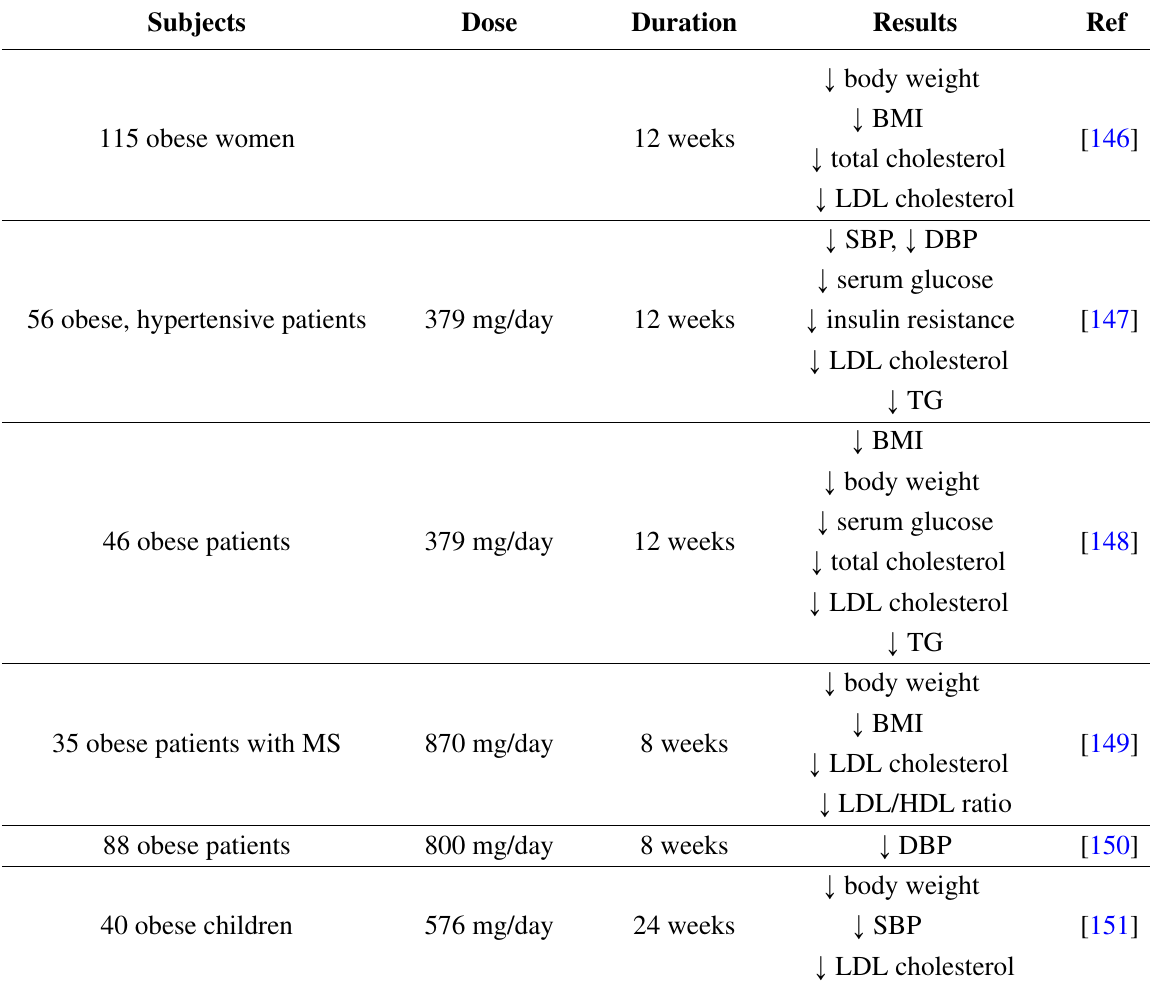
Table 3. Properties of EGCG on human